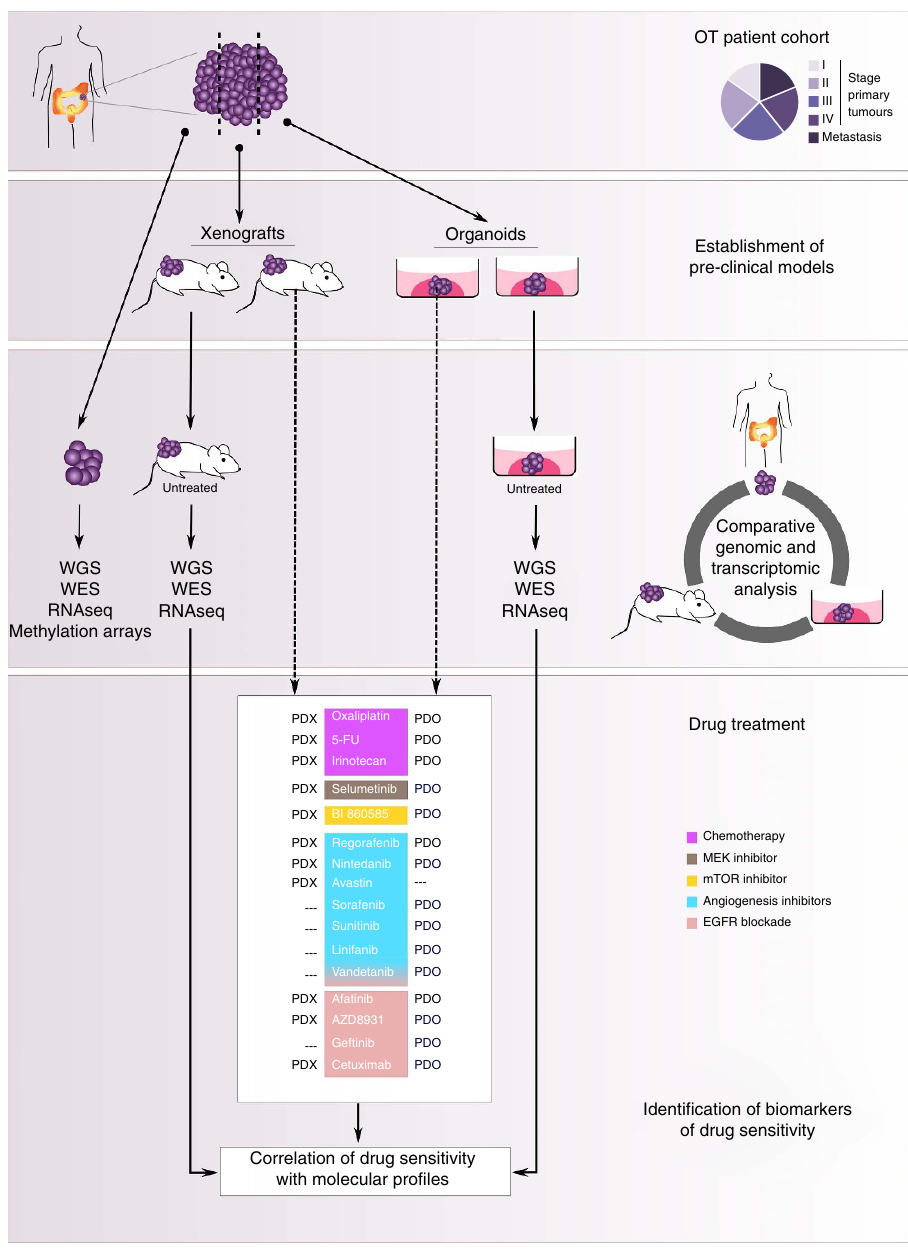
Figure 1 | Experimental design of the OncoTrack (OT) study. Resected CRC patient tumours were fragmented and sampled for fuelling the sequencing and the establishment of in vivo PDX and in vitro PDO models. Untreated original tumours, PDX and PDO samples were analysed by WGS, WES and RNAseq for correlating the molecular information with drug sensitivity patterns. In addition, the epigenomes of the original tumours were analysed. The OT pre-clinical platform treated both model systems with therapeutic compounds representing the standard of care and/or addressing major pathways relevant in